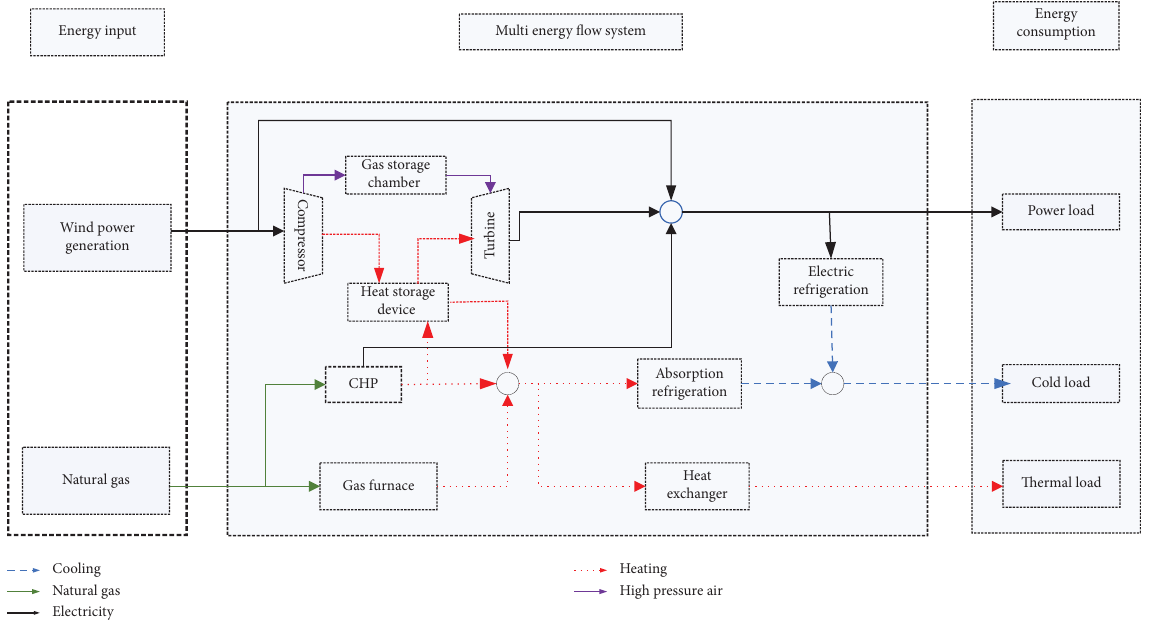
Figure 1: Multienergy fow system